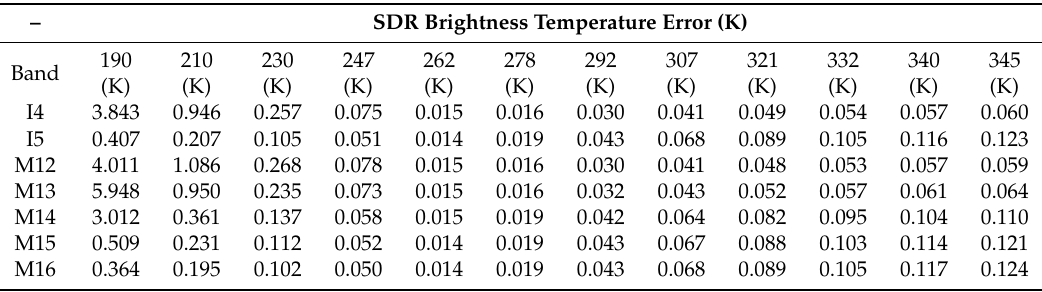
Table 4. Maximum Sensor Data Records (SDR Brightness Temperature Error (K) Due to 0.2% RVS Shape Error at Multiple Scene Temperatures (K) for all